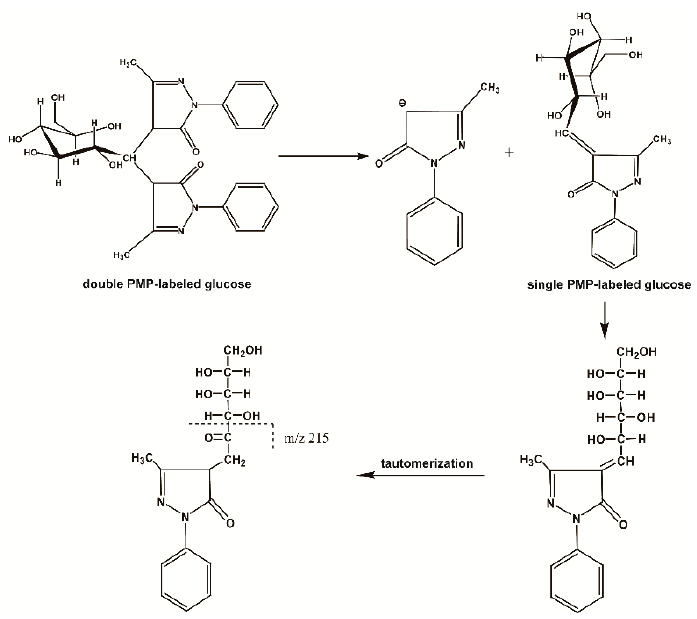
Figure 4. Fragmentation pathway of double PMP-labeled monosaccharides in ESI-MS n .